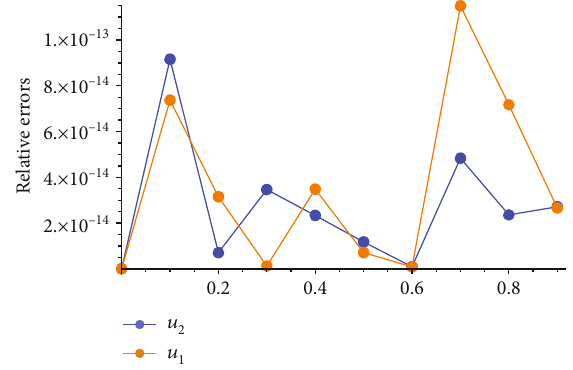
u 1 and 2 obtained by the present